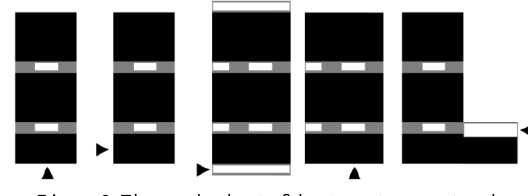
Figure 7. The ventilation mode chart of the cluster